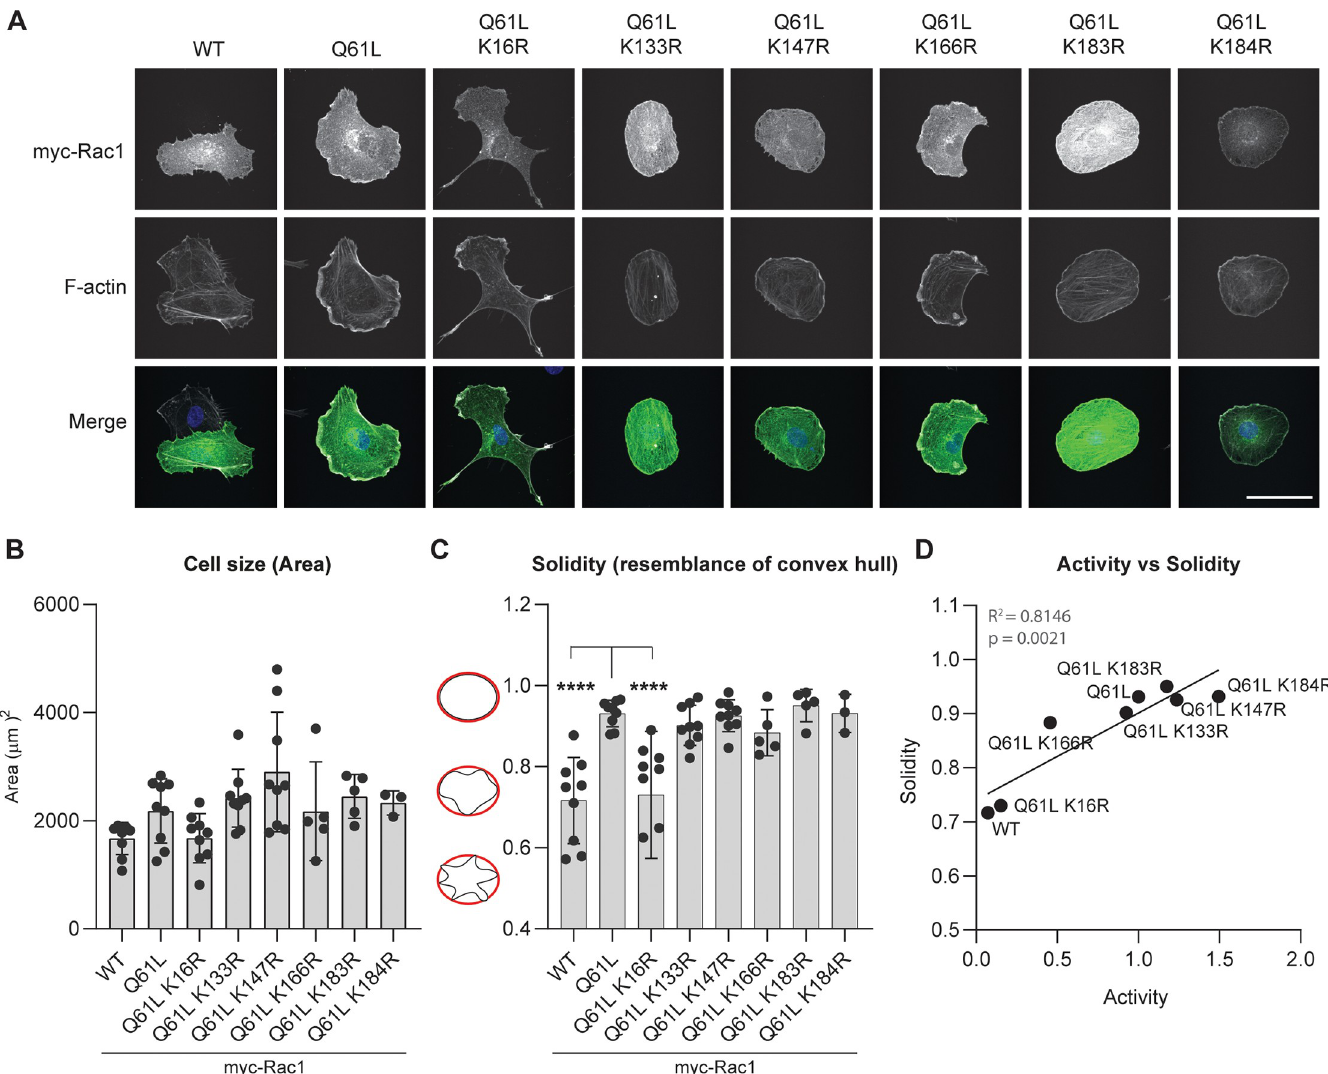
Fig 6. Morphological effects of myc-Rac1 K-R mutants in HUVECs. A) Immunofluorescent analysis of myc (green) and F-actin (gray) of HUVECs with transient overexpression of myc-Rac1 and mutants. Scale bar represents 50 μ m. B) Quantification of cell size defined by surface area covered. C) Quantification of cell shape solidity of > 5 cells per sample. ���� p < 0.001 compared to Q61L in Holm-Sidak’s post-hoc test of one-way ANOVA. D) Correlation graph with linear regression of the solidity versus activity levels of mCherry-Rac1 activating mutants.